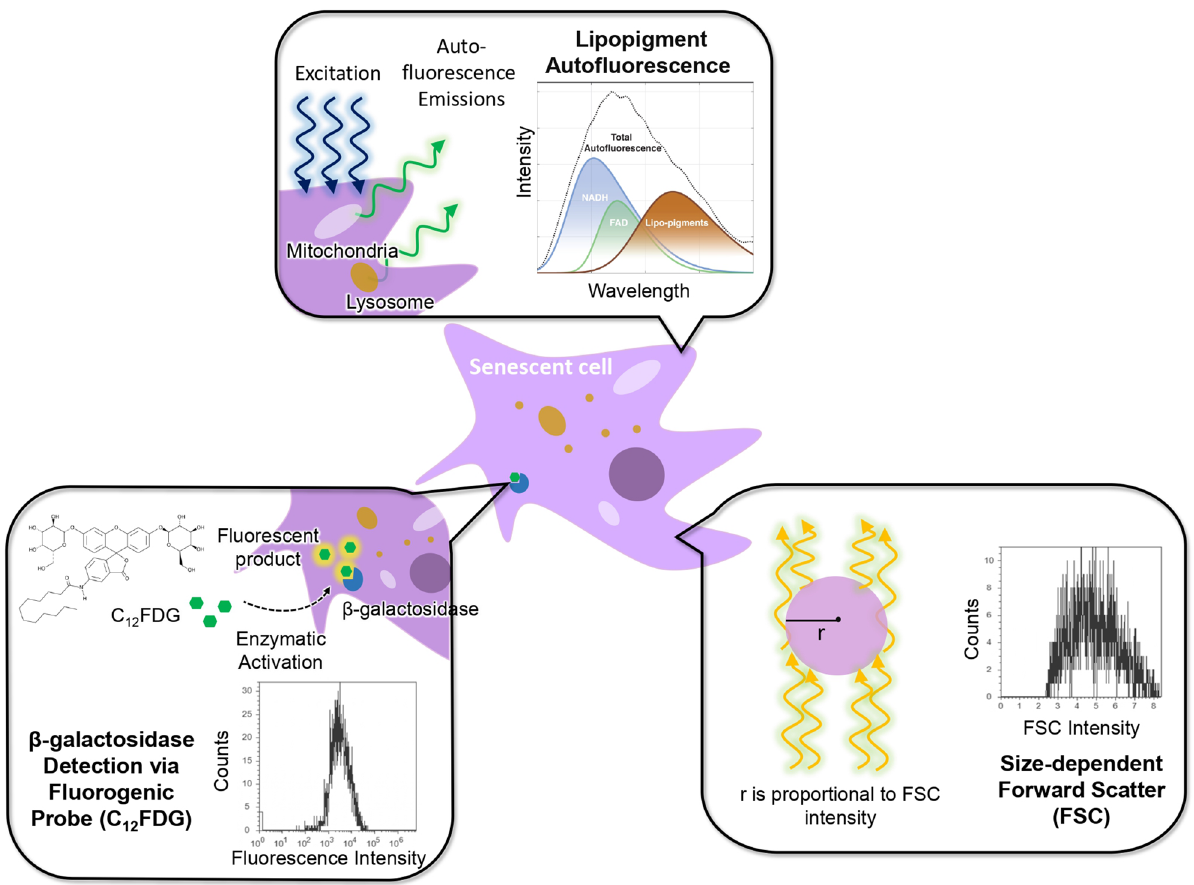
Figure 1. Various methods used for automatic quantification of hMSCs senescence in this study. Top: New autofluorescence method that employs cell lasing through endogenous fluorophores to collect autofluorescence signals. Bottom left: fluorescence-based detection of β -galactosidase activities using fluorogenic substrate C 12 FDG through enzymatic activation and flow cytometry analysis. Bottom right: flow cytometry forward scatter (FSC) measurements for hMSCs cell size determination. All three flow cytometer and autofluorescence methods in quantification of hMSCs senescence were benchmarked with the cytochemical β -galactosidase staining